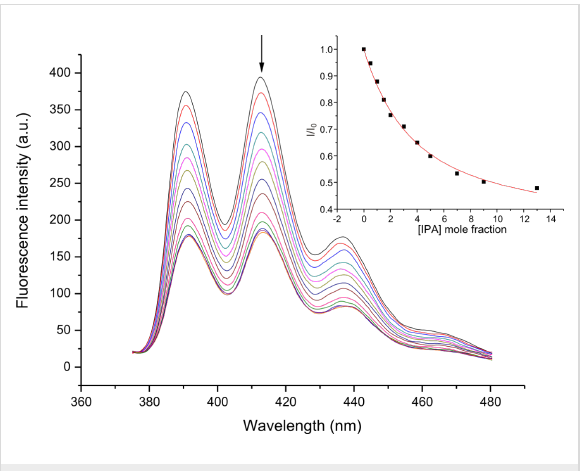
Figure 1: The changes in the fluorescence emission spectra of sensor 1 (5.0 × 10 − 6 M) upon addition of isophthalate in acetonitrile. λ ex = 366 nm. (Inset) Quenching ratio of sensor 1 as a function of (guest)/(host).